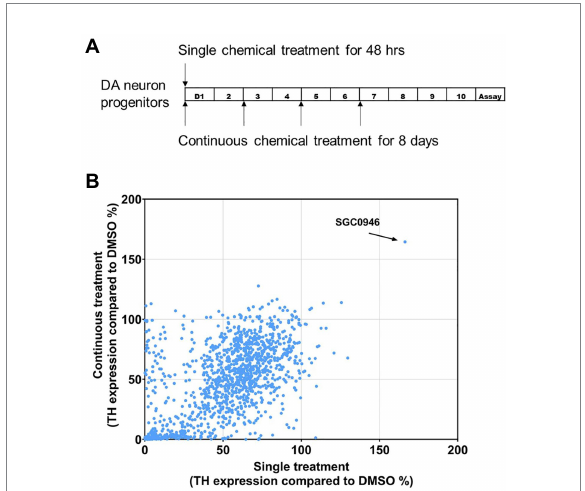
FIGURE 1 Screen of Tocriscreen 2 chemical library. (A) Experimental design. Day 18 DA neuron progenitors were plated and cultured for 10 days with DMSO only (Control) or treated with chemicals during the first 48 h (single treatment) or 8 days (continuous treatment). Luciferase readings were done at the end of the 10- day differentiation. (B) Screen results. TH expression was detected using the luciferase assay and normalized to the treatment with DMSO only. X-axis represents the reading of single chemical treatment and Y-axis represents continuous treatment for 8